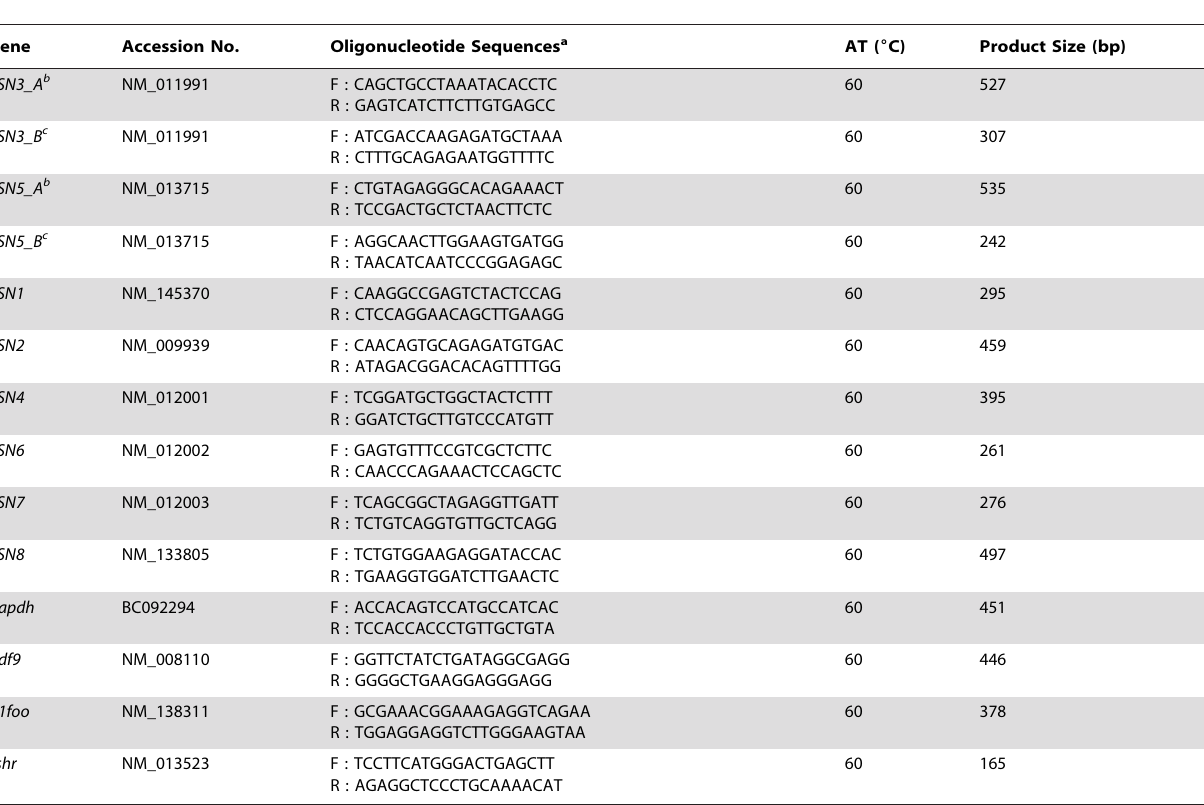
Table 1. Sequences of oligonucleotide primers and their expected RT-PCR product sizes.